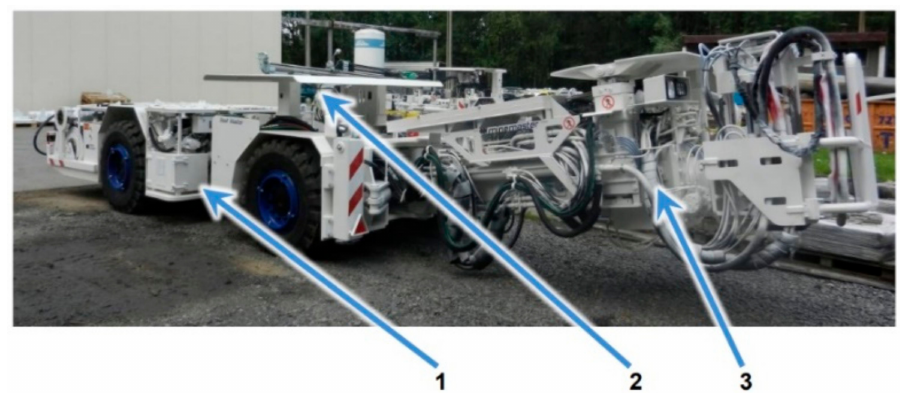
Figure 4. Drilling and bolting rig—Roof Master 1.4 and Mine Master Sp. z o. o.